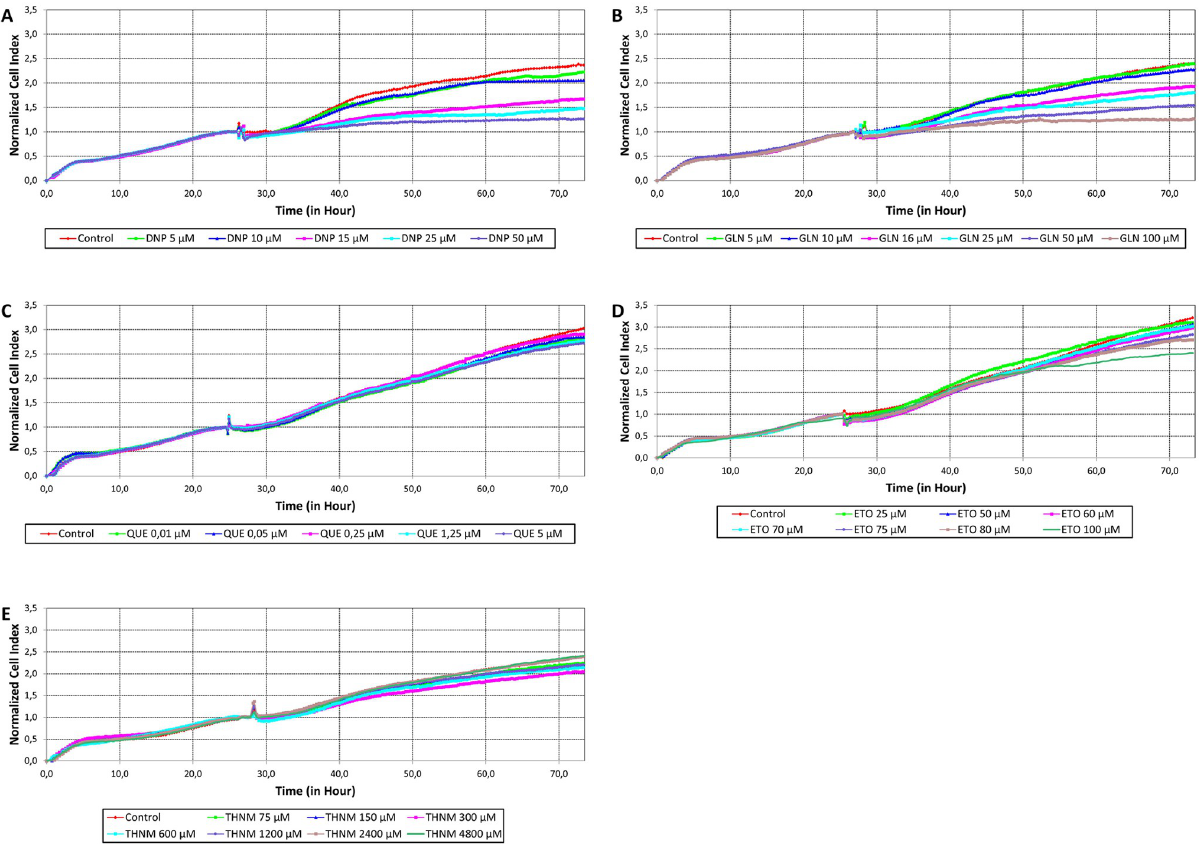
Fig 6. The results of the RTCA analysis: The cells were not treated with any drug for the first 24 h. After 24 hour, different concentrations of donepezil (A), galantamine (B), queuine (C), etoperidone (D), and thiamine (E) were applied. Following drug application, cell index was measured over time for 48 hours and